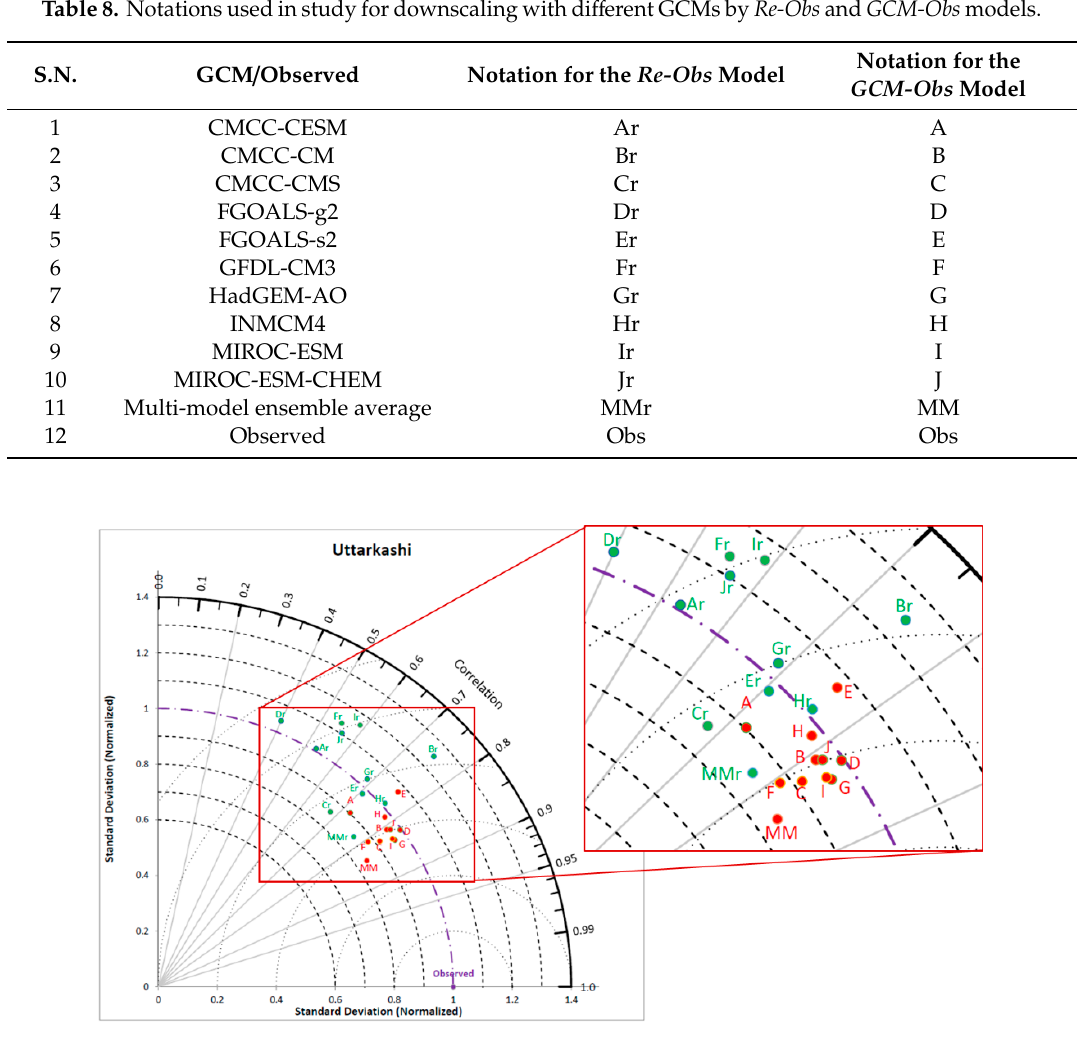
Figure 13. Taylor diagram for downscaling with Re-Obs and GCM-Obs models for Uttarkashi. Notations are same as the ones used in Figure 8.